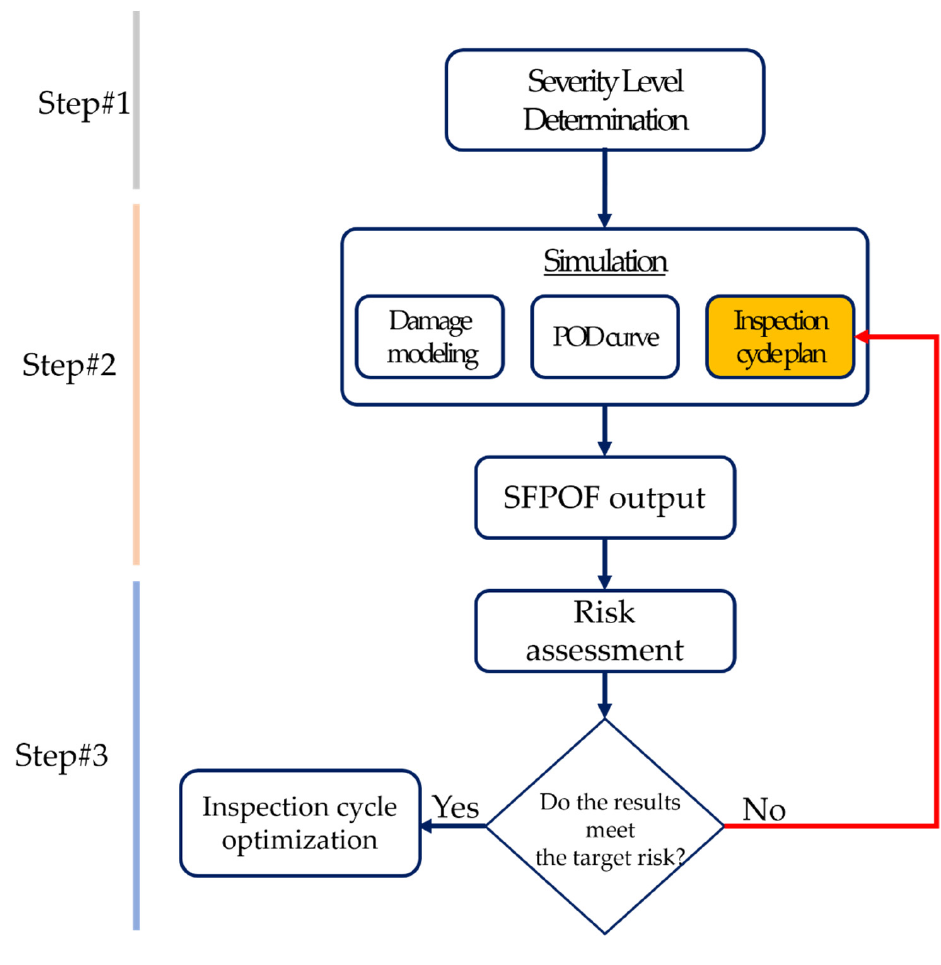
Figure 16. Process of determining the optimal inspection cycle.